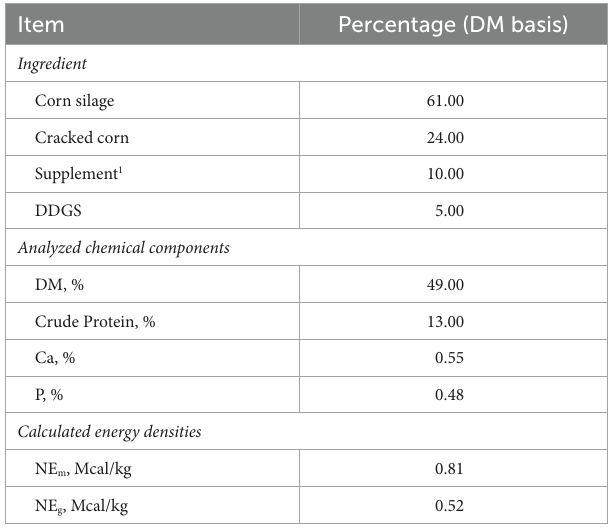
TABLE 1 Composition of experimental diet fed to